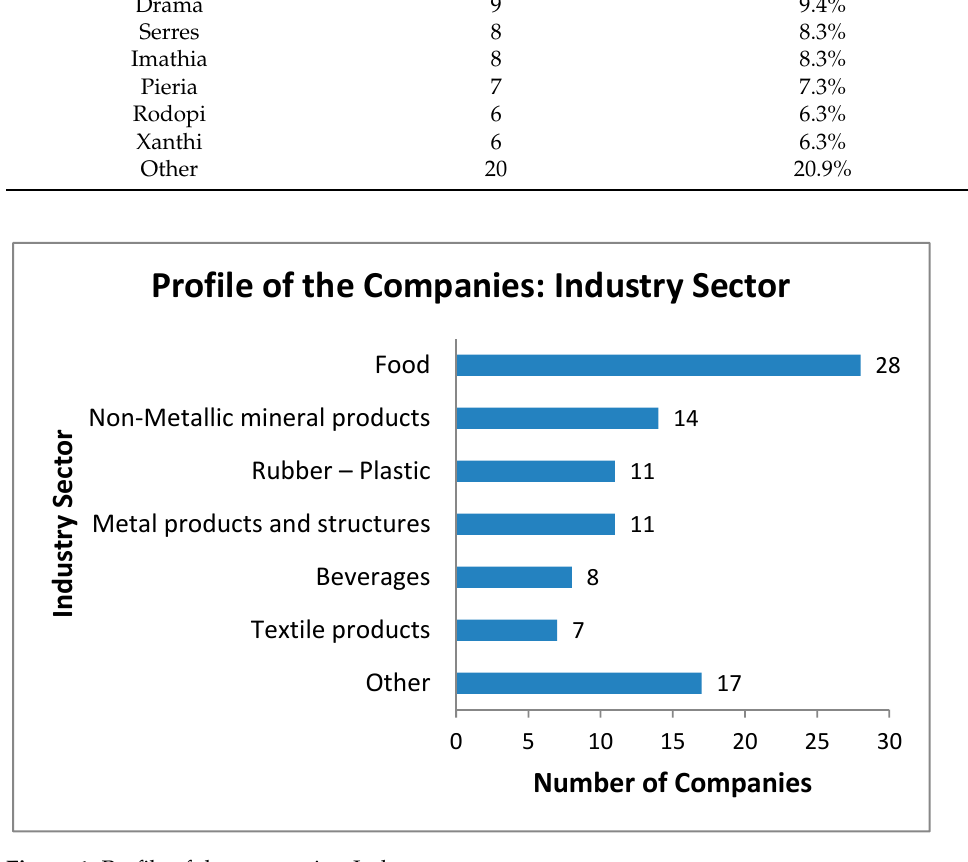
Figure 1. Profile of the companies: Industry sector.